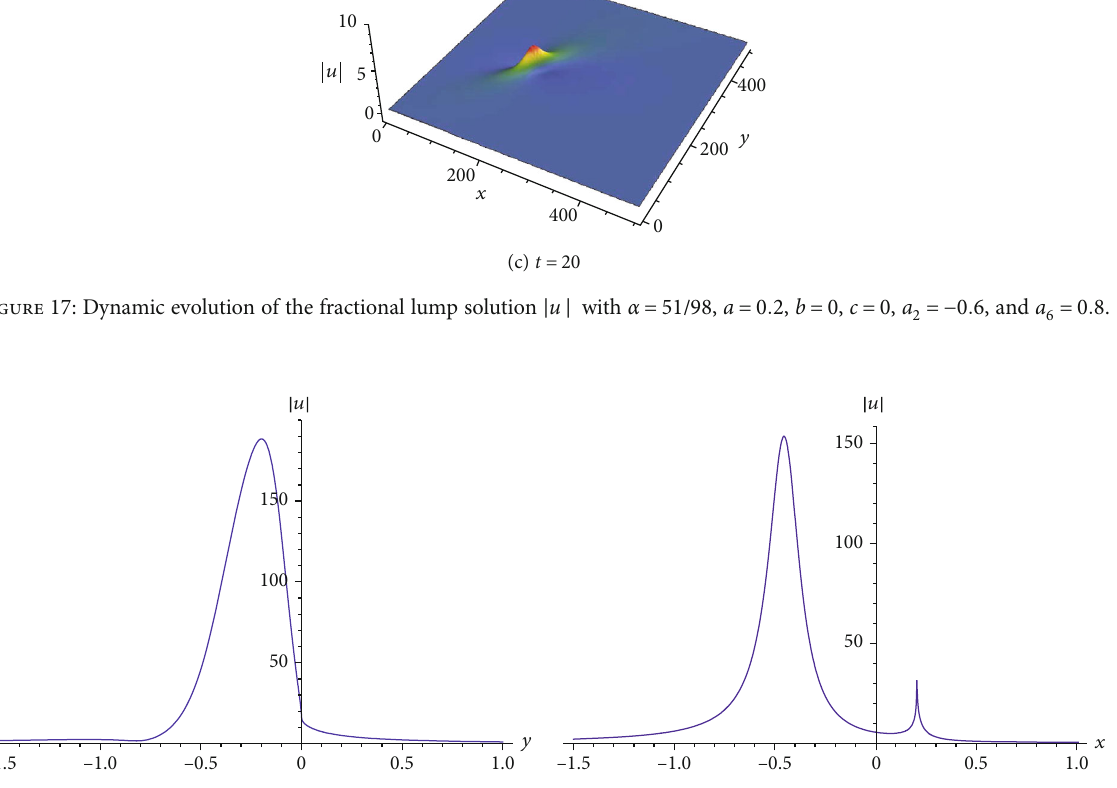
–1.5 Figure 18: Pro fi les of the fractional lump solution ∣ u ∣ with α = 51/98 , a = 0 : 2 , b = 0 , c = 0 , a